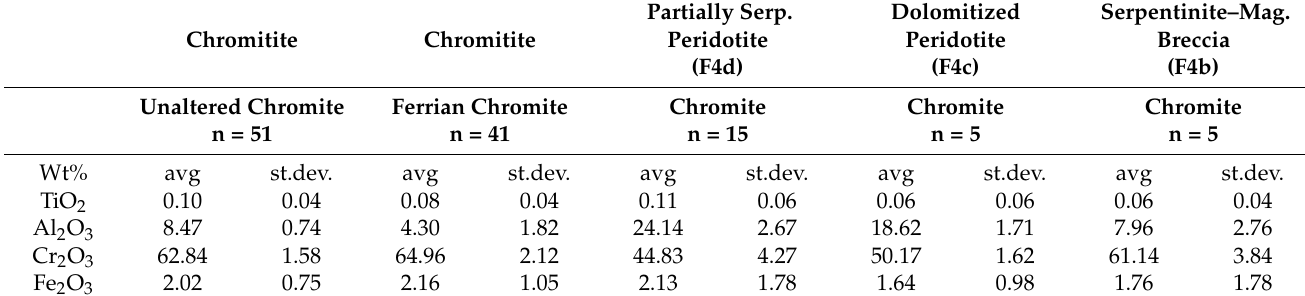
Table 1. Major and minor elements average composition and standard deviation of chromite cores from Kymasi lithologies; Mg# = [Mg/(Mg + Fe 2+ )]; Cr# = [Cr/(Cr + Al)]. Fe 2 O 3 and FeO are